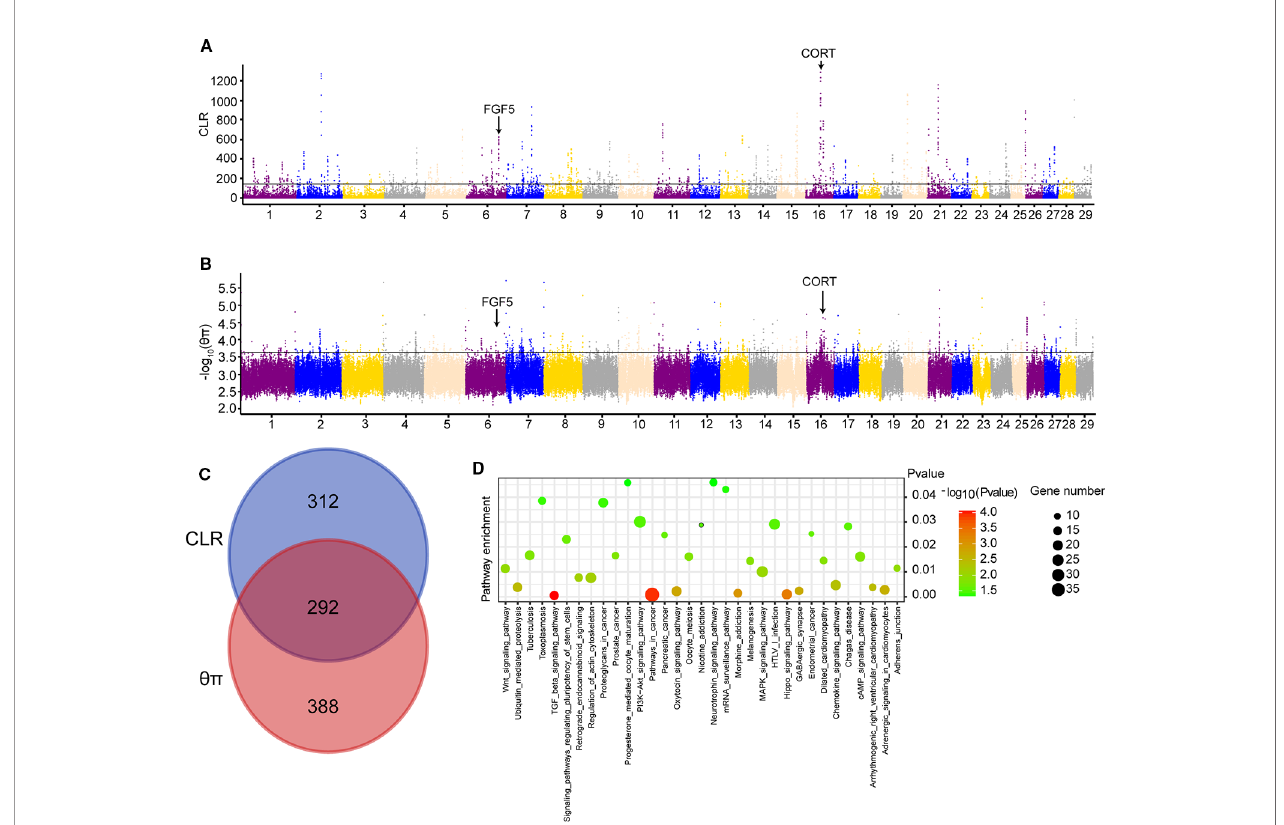
FIGURE 1 | Genome-wide selection scan in Yanbian cattle. (A, B) Manhattan plot of the genome-wide distribution of composite likelihood ratio (CLR) and qp in Yanbian cattle using 50 kb windows size and 20 kb step size, respectively. (C) Venn diagram showing the genes overlap among CLR and qp signi fi cant selection region. (D) Kyoto Encyclopedia of Genes and Genomes (KEGG) pathway analysis of differentially expressed genes. Advanced bubble chart shows enrichment of differentially expressed genes in signaling pathways. Y-axis label represents pathway, and X-axis label represents rich factor (rich factor = amount of differentially expressed genes enriched in the pathway/amount of all genes in background gene set). Size and color of the bubble represent amount of differentially expressed genes enriched in pathway and enrichment signi fi cance,